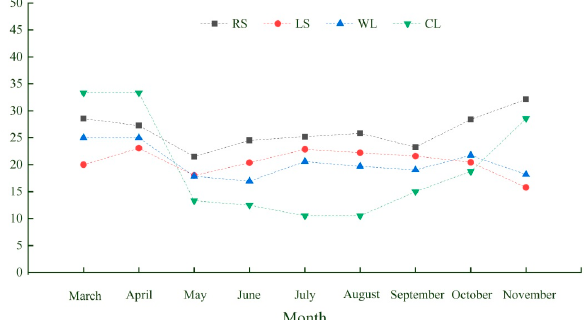
Figure 7. Spatiotemporal variations in the proportion of alien invasive plant species to all sponta- neous plant